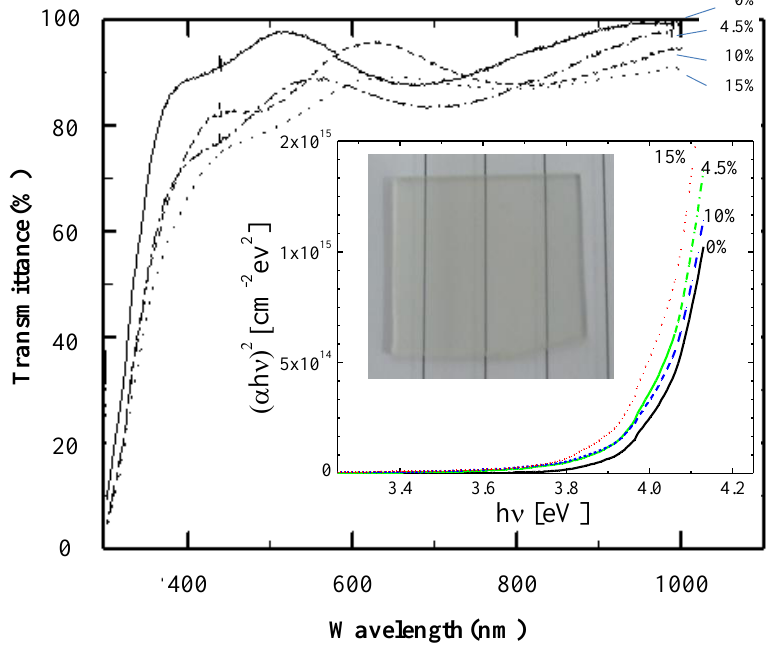
Figure 4. Transmittance spectra of SnO concentrations. Insets: plots of (αh  ) 2 vs. h  (photon energy) and photograph of 4.5 wt.% F-doped films (Area: ~1 inch 2